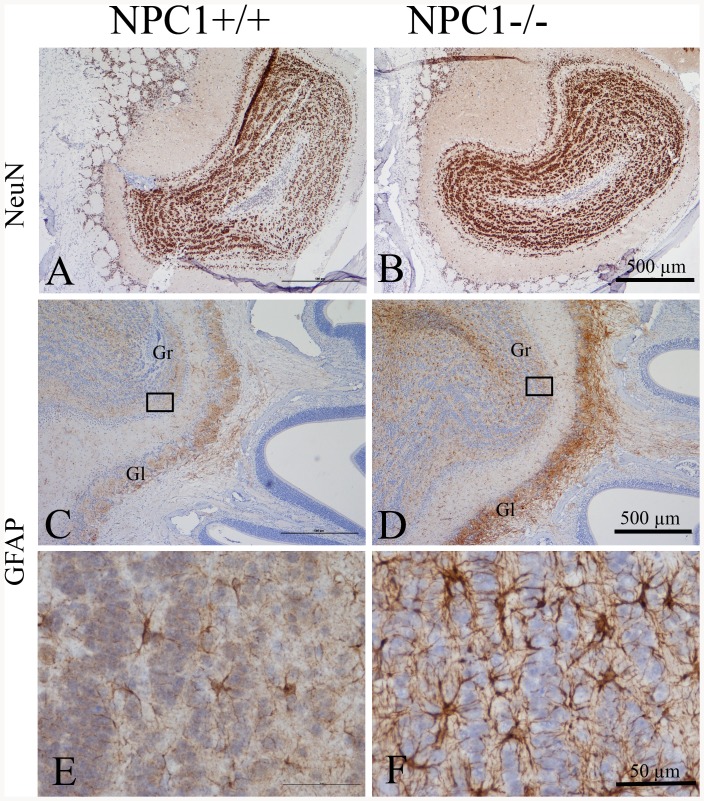
Immunohistochemistry of NeuN (A, B) and GFAP (C through F) in the OB.Distribution of NeuN-positive neuronal cells do not reveal any obvious differences between NPC1+/+ (A) and NPC1−/− mice (B) (67–70 d). There is a clear increase of GFAP expression, especially in the glomerular layer (Gl) in NPC1−/− animals (D) compared to NPC1+/+ (C). The area marked by the rectangles is enlarged in E and F, respectively, demonstrating the astrogliosis of the granular layer (Gr) in NPC1−/− mice. Counterstained with hematoxylin.